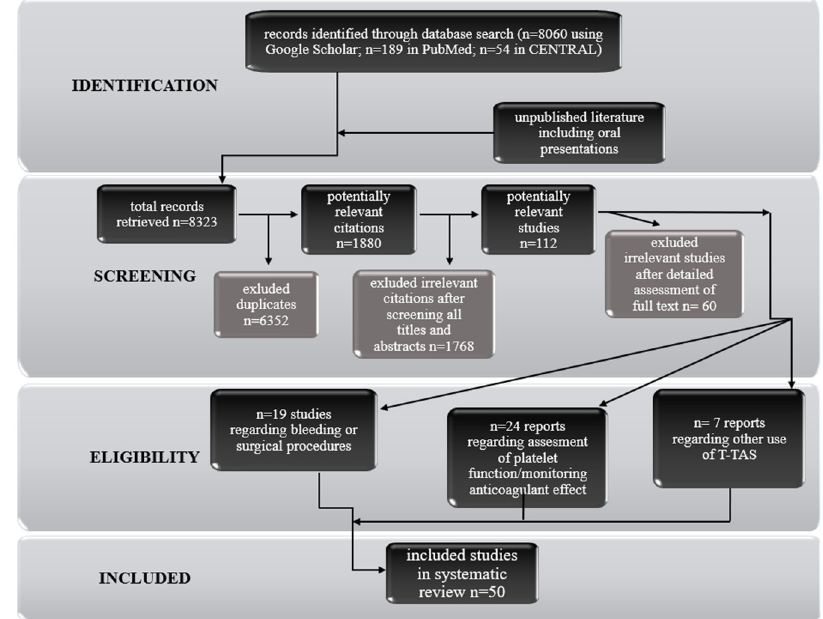
Figure 2. Flow chart of studies